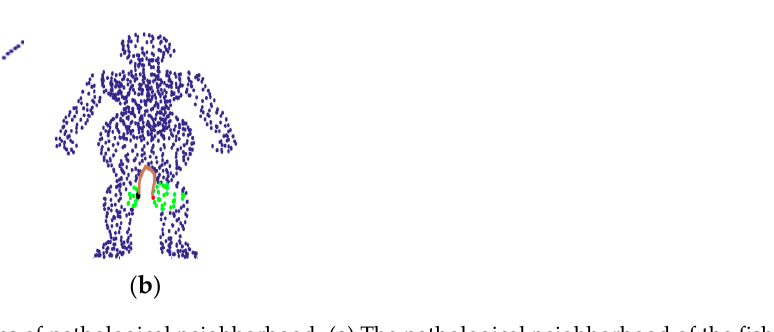
Figure 1. Examples of pathological neighborhood. ( a ) The pathological neighborhood of the fishing rod. ( b ) The pathological neighborhood of the knee.